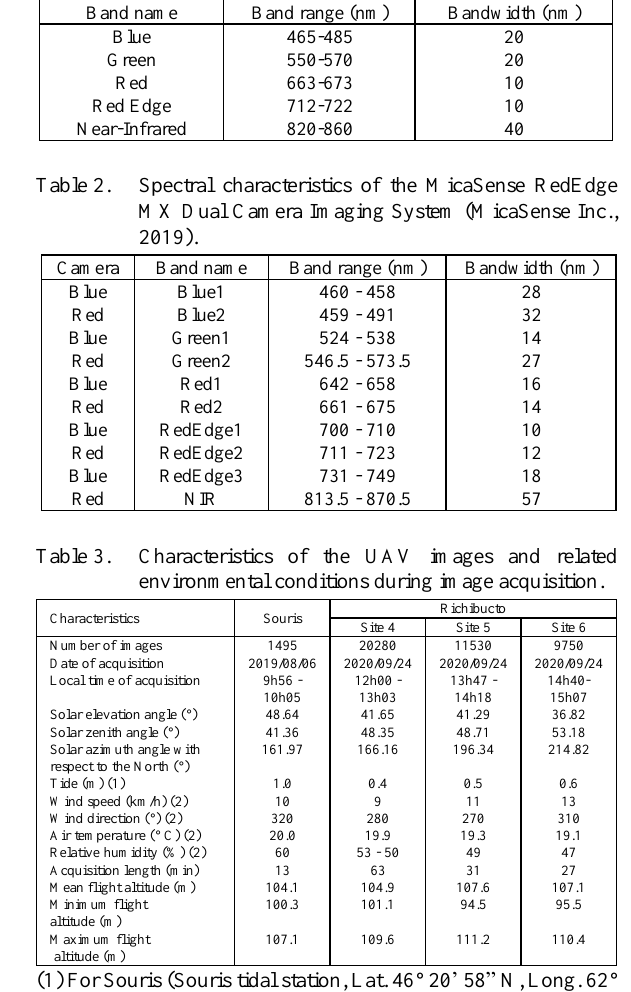
Figure 3. Sonar tracks overlaid over an RGB composite made with the Sentinel-2 image for a) Souris, b) site 4 of Richibucto, c) side 5 of Richibucto, and d) site 6 of Richibucto